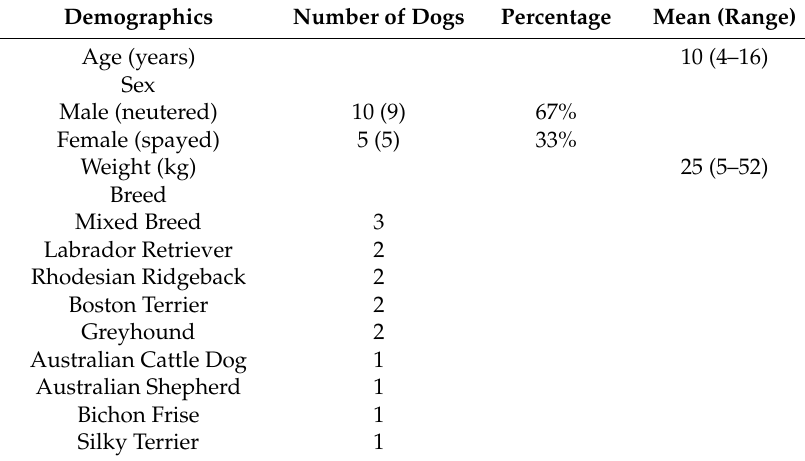
Table 1. Canine patient